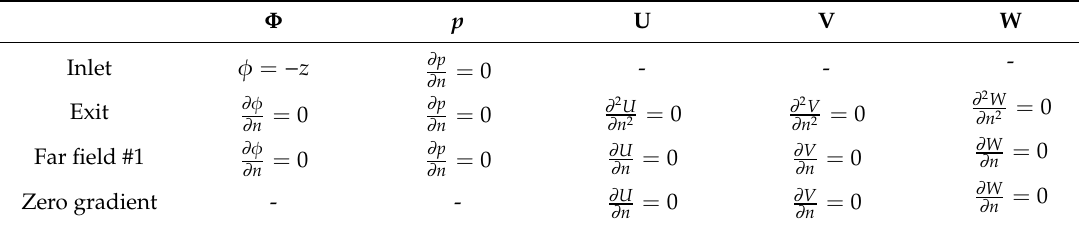
Table 3. The CFD computational domain size of the full-scale (half hull).